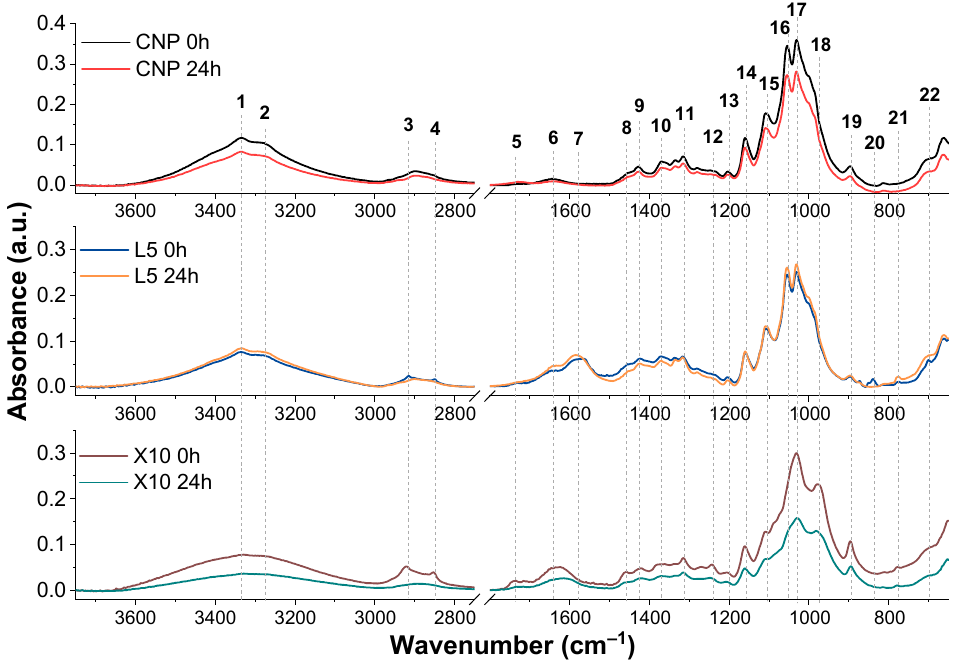
Figure 9. FTIR spectra of CNP, L5, and X10 samples before and after 24 h UV irradiation. The FTIR region between 1800 and 2800 cm − 1 is emitted because it lacks any significant bands.